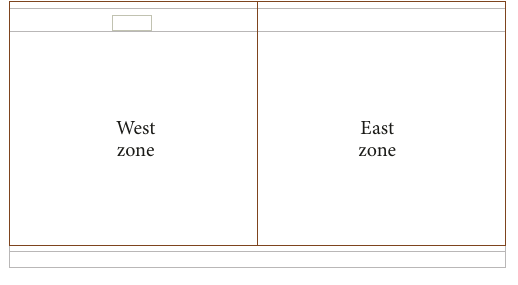
Figure 4: Two-zone data center building. Table 1: The average Silhouette scores for different numbers of